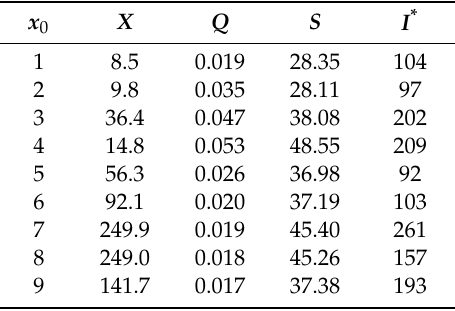
Table 4. Initial conditions for each culture run (Physical units are defined in Table A1).